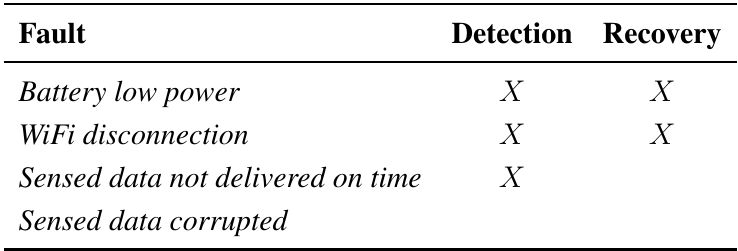
Table 4. Example of Fault Coverage for Case Study 1.